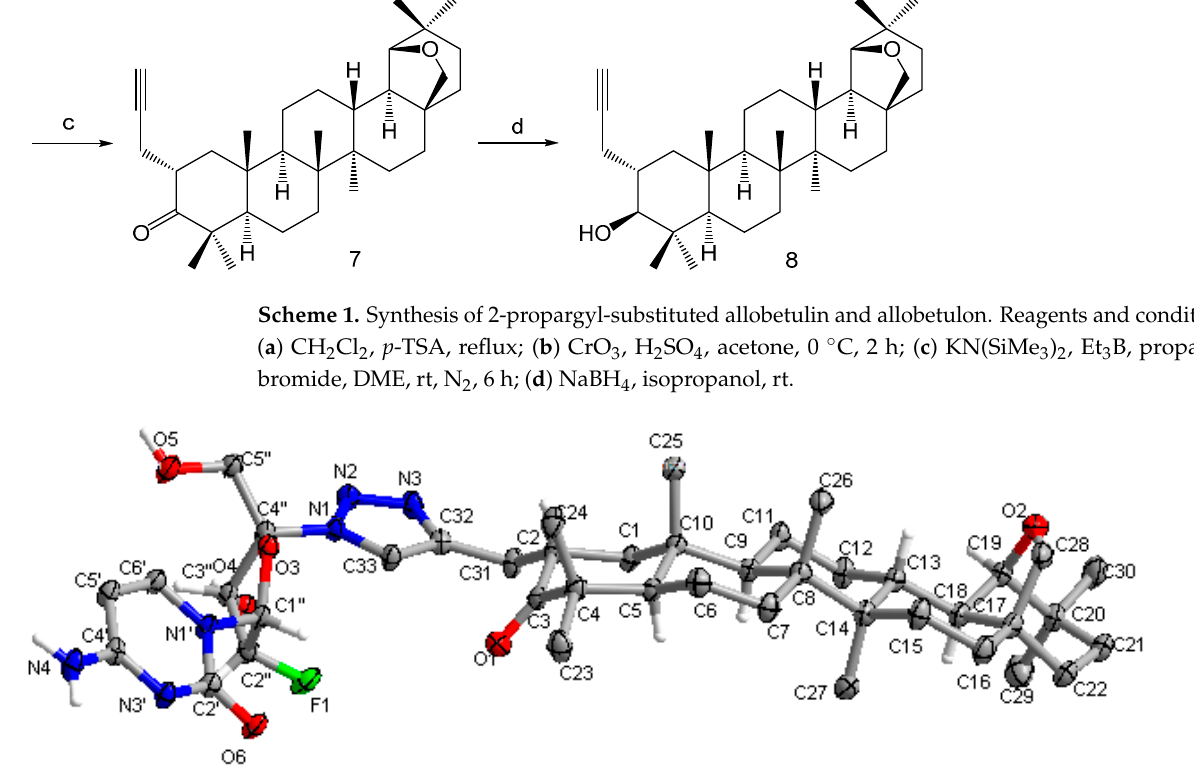
Figure 2. X-ray crystallographic structure of compound 9c .